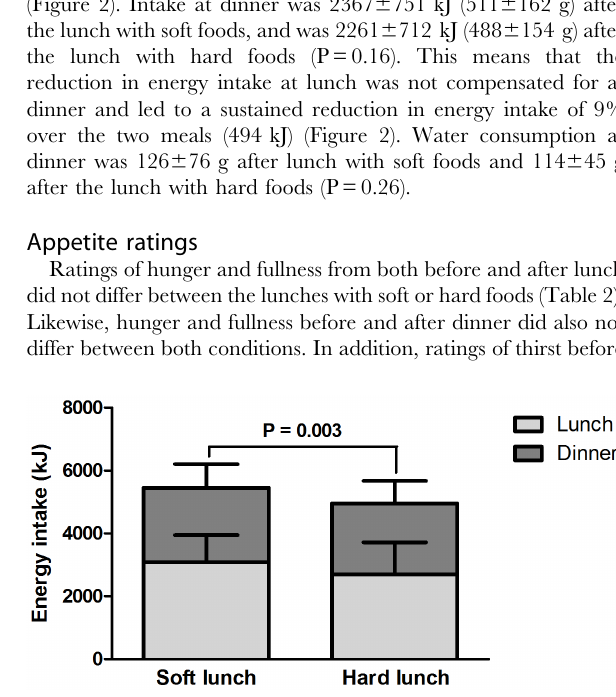
Test foods Ingredients